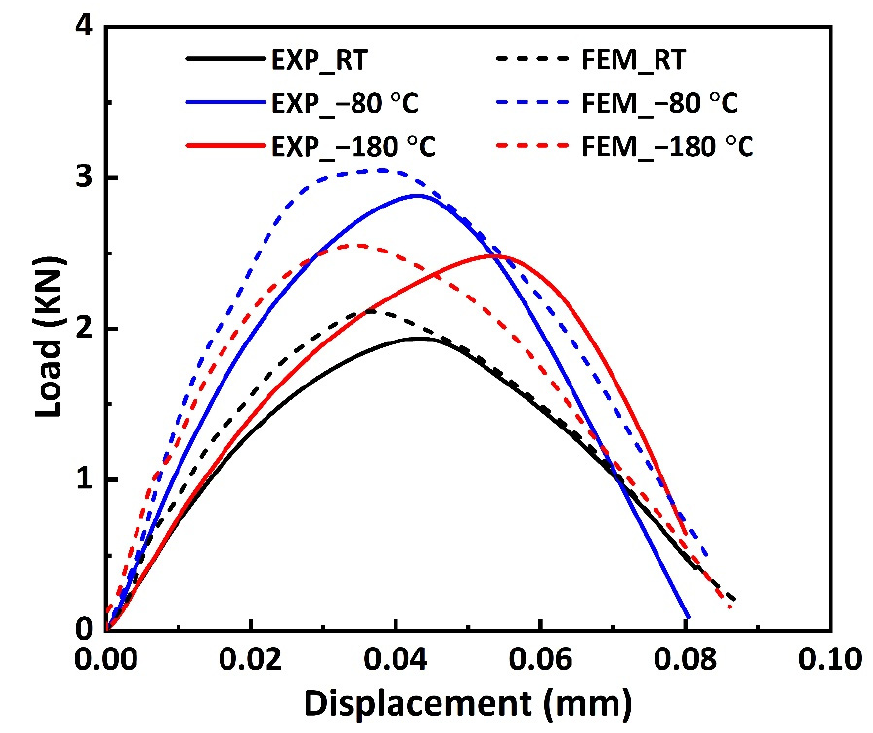
Figure 11. Load–displacement curves of the dynamic bending samples at different temperatures and 10 m/s impact velocity.